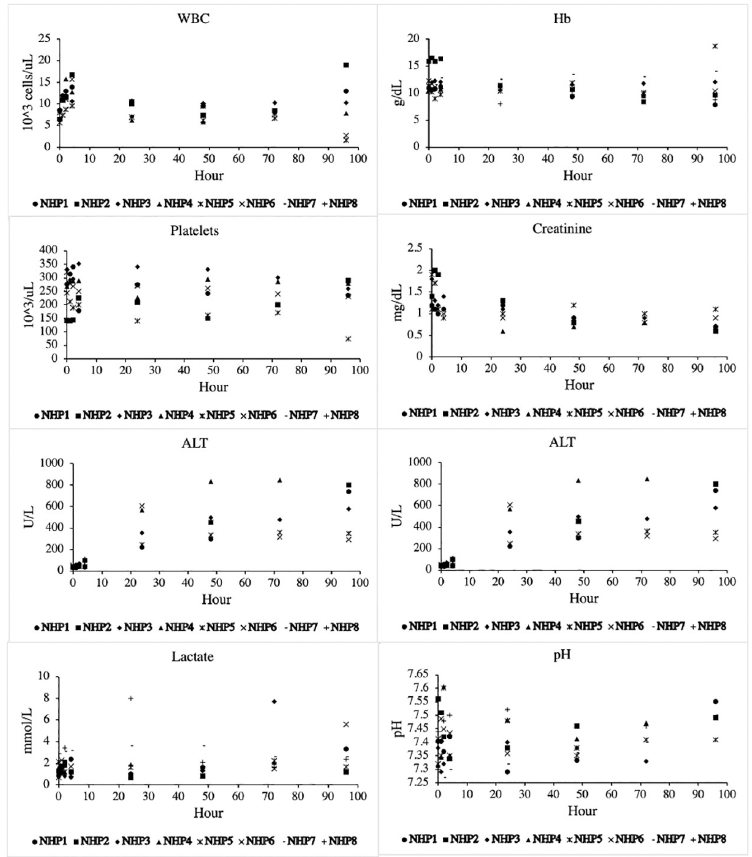
Fig 2. Selected hematologic and chemistry results. � denotes statistical significance from baseline values (p < 0.05).